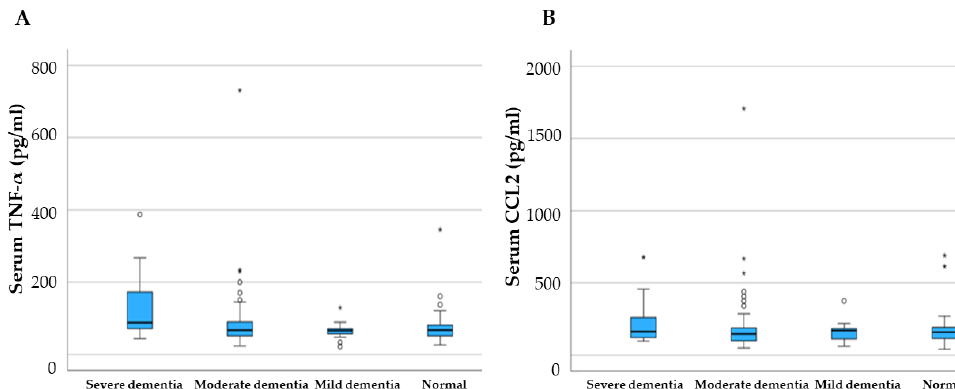
Figure 3. Cognitive decline measured with ACEIII in relation with serum levels of ( A ) TNF- α and ( B ) CCL2. TNF- α and CCL2 serum levels are not associated with severity of cognitive decline ( p > 0.05). * represents the extreme